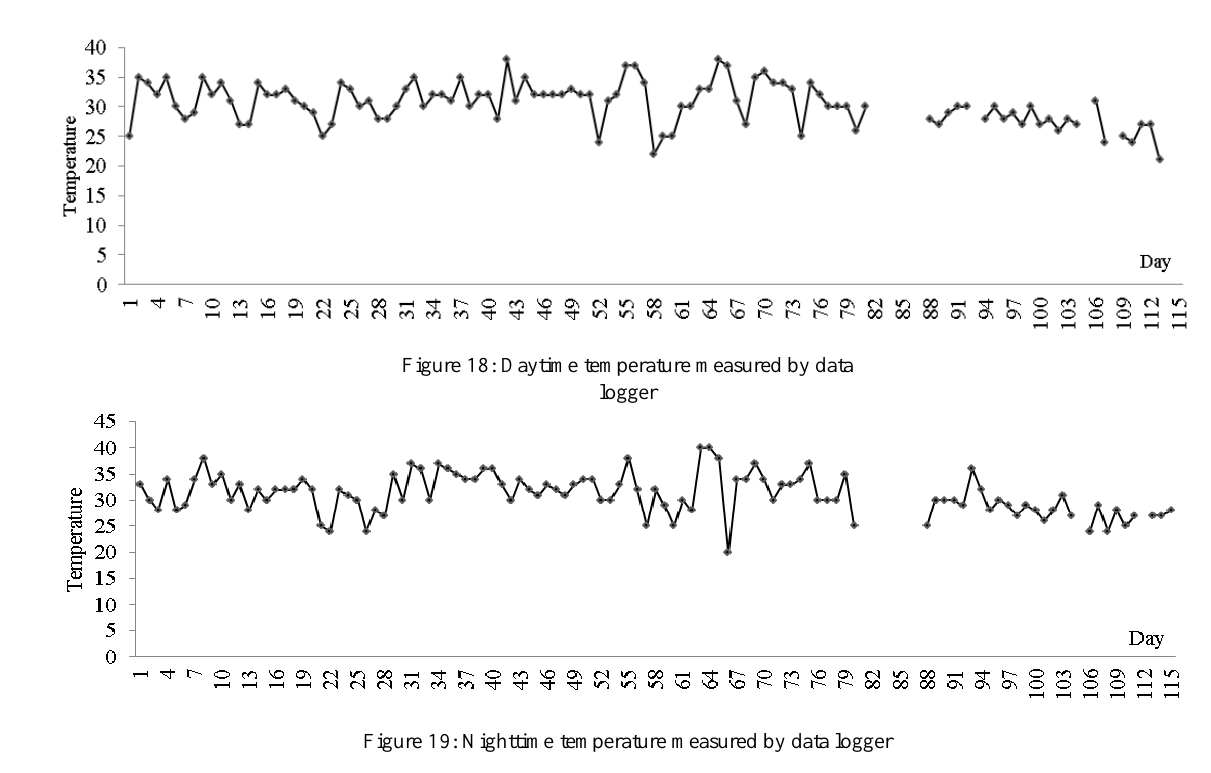
Figure 16: Daytime Relative humidity measured by data logger